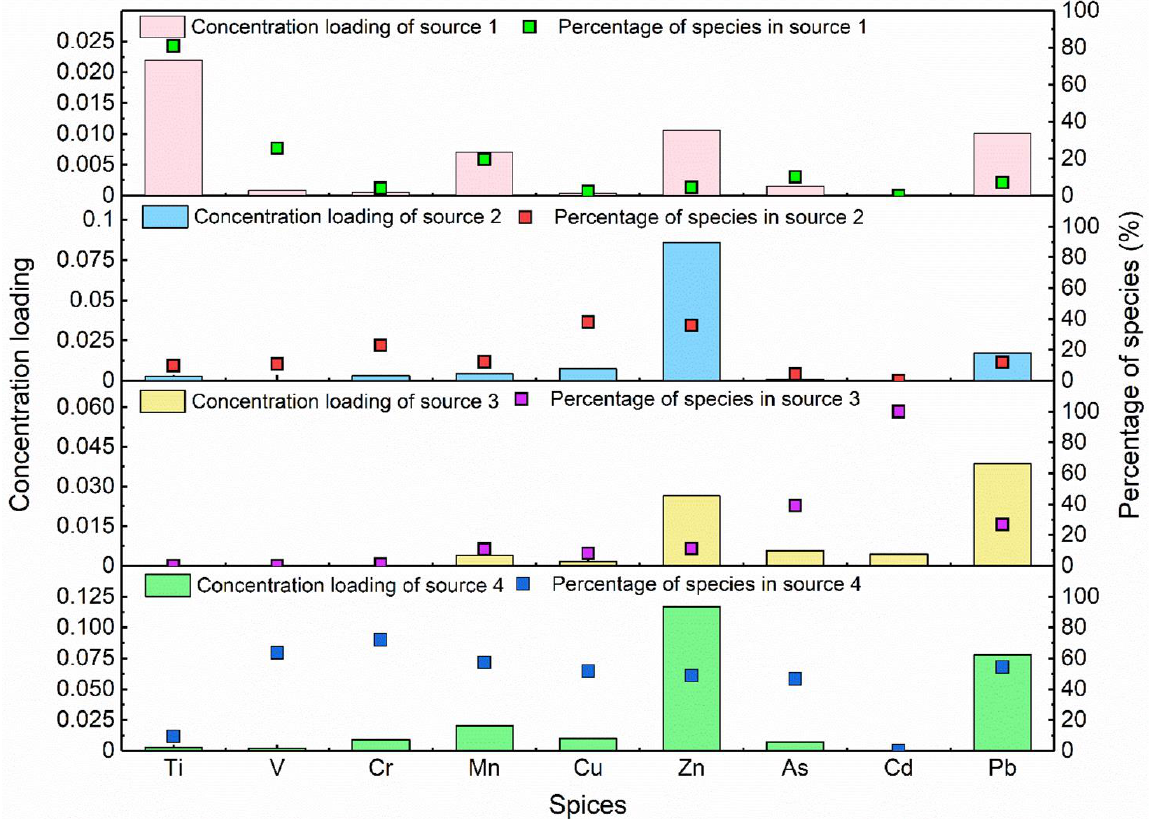
Figure 4. Source composition resolved by Unmix. Source 1 demonstrated high concentration loadings of Ti (80.82%) and Mn (26.53%). Ti and Mn are seen as sign species for crustal elements [19,44,45]. A small amount of the concentration loading of Mn came from ground praise dust [46]. The time series of the contribution of source 1 was at relatively low level throughout the three years. In partic- ular, the contribution of source 1 in July was much lower than that of other months. The contribution of dust to the concentration of the heavy metals in PM 2.5 was reduced due to the abundant rainfall in Handan in July. Hence, source 1 can be defined as a source from soil dust (SD). Source 2 showed high concentration loadings of Cr (23.04%), Cu (37.95%), Cd (29.46%), and Zn (35.79%) and a few loadings of Pb (11.92%). The brakes of motor vehicles release Cr during their period of operation, which enrich in the environment. Atiemo et al. (2011) found that high concentrations of Cu and Zn come from tire abrasion, lubricants, and the wearing of brake linings [47]. Cd and Pb can be released from multiple different sources in the environment, such as vehicle emissions [13,48]. In addition, the contribution of source 2 was decreased in the three years, which are related to the measure for vehicle control. Above all, source 2 can be classified as vehicle emissions (VEs). Source 3 demonstrated loadings of As (38.99%), Cd (70.54%), and Pb (26.89%). Cd in PM 2.5 is mainly produced by coal dust such as coking plants and steel plants [49]. As is widely used as a marker for coal and fuel combustion. Ge et al. (2014) found that Pb is mainly attributed to civil coal combustion emissions [50]. Rural residents in the suburb of Handan are used to heating or cooking by large amounts of honeycomb coal in winter. Time series of source 3 contribution exhibited the highest contributions in January. Janu- ary is attributed to the heating period in Handan, causing a large amount of PM emissions by burning coal. Therefore, we can deduce source 3 is from coal combustion (CB).